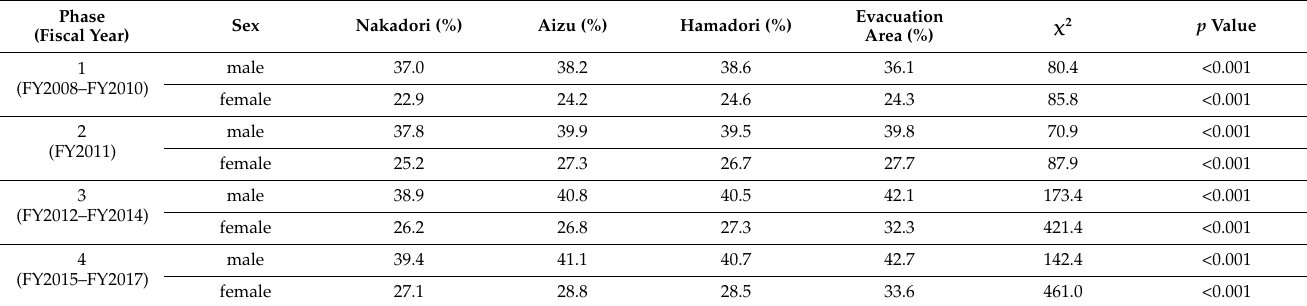
Table 2. Regional comparison of the prevalence of dyslipidemia in each phase.